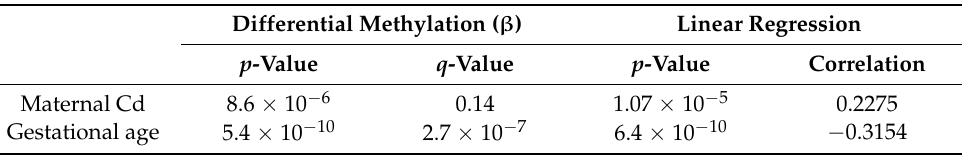
Table 3. Differential methylation patterns of cg21010642 and its correlation with maternal Cd levels and gestational